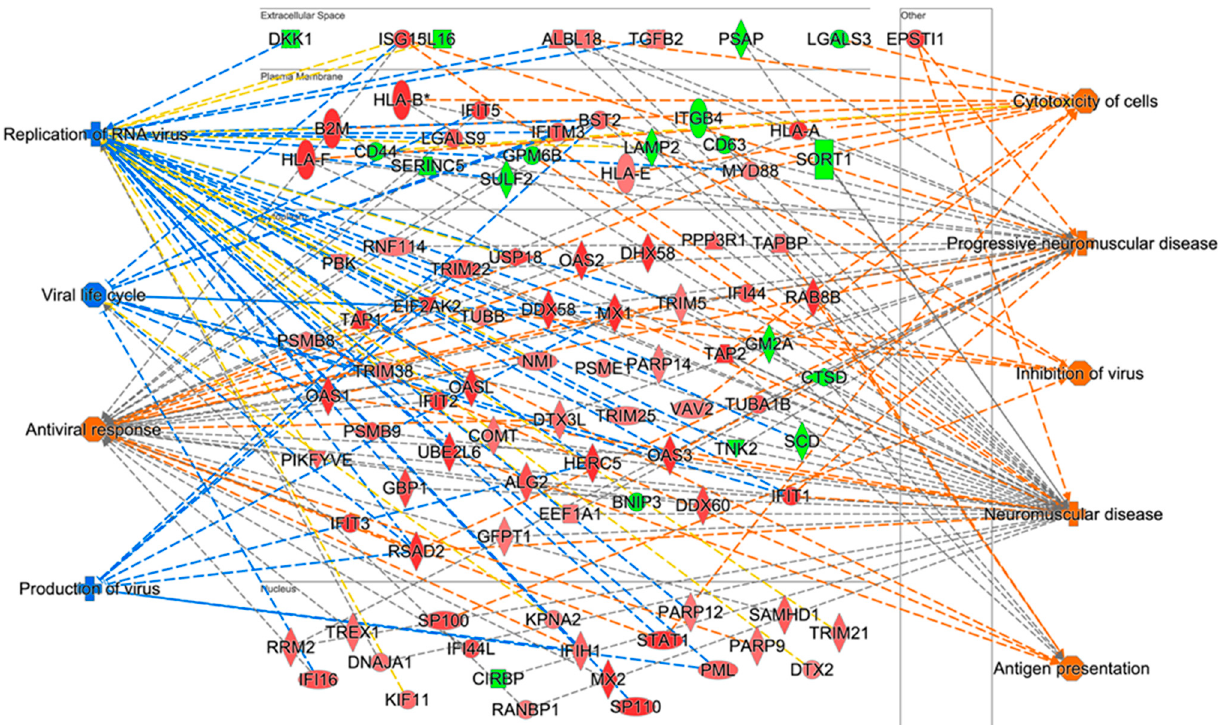
Figure 3. Predicted dysregulation of host cell diseases and functions at 48 hpi. Cut off p -value is 0.05. Z-score threshold is +/ − 1.96 σ . Green represents U251 proteins that were significantly under-expressed by ZIKV infection compared to their time-matched mock-infected samples, while red represents proteins that were significantly over-expressed by infection compared to their time- matched mock-infected samples. 2-tailed Students t -test and Z-score analyses were used to determine the statistical significance. Orange represents predicted activation of the cellular function and disease, and blue represents prediction inhibition as generated by IPA software based on the statistically significant data from the comparison of ZIKV-infected U251 cells to time-matched mock- infected U251 cells at 48 hpi.